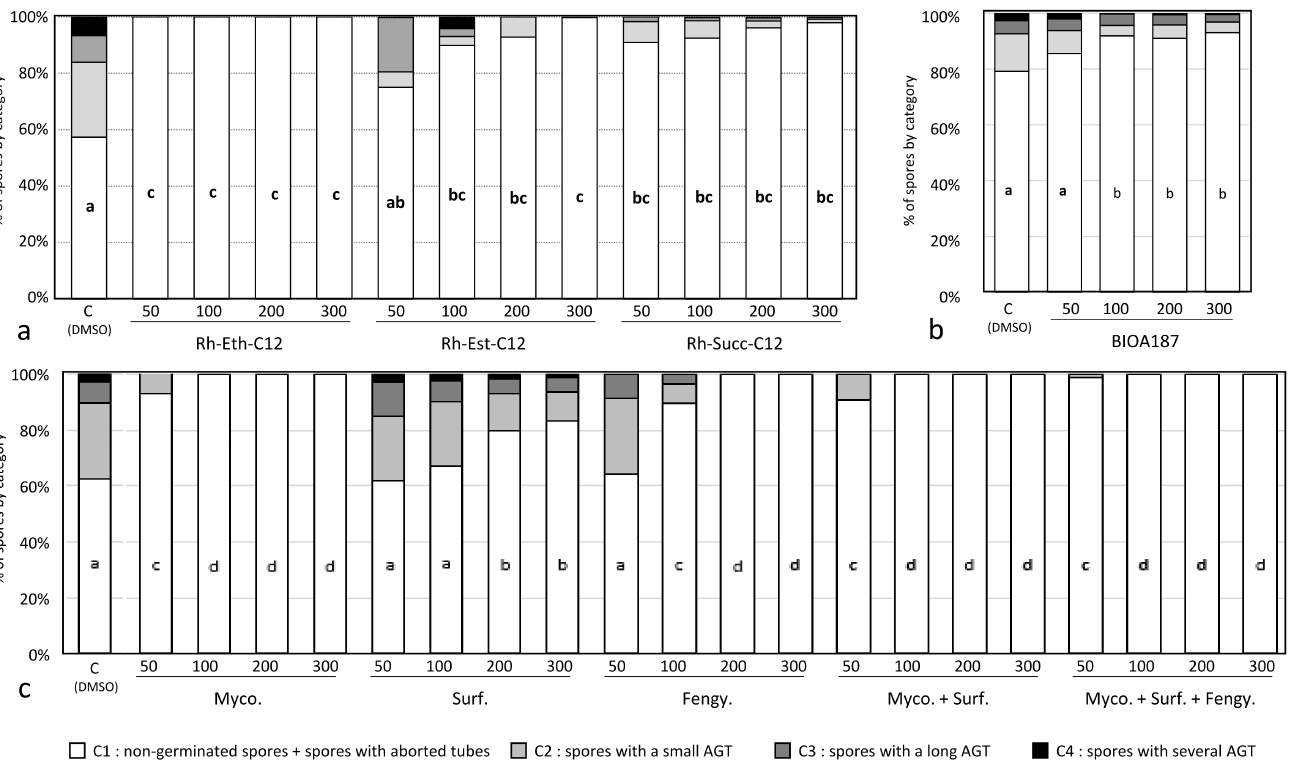
Figure 5. Effect of the molecules on the germination of B. graminis f.sp. tritici spores in vitro. The spores are classified in 4 different groups: C1, non-germinated spores + spores with aborted tubes; C2, spores with a small AGT; C3, spores with a long AGT and C4, spores with several AGT. The spores were in contact with synthetized rhamnolipids ( a ), BioA187 ( b ), lipopeptides and its mixtures ( c ) and 0.1% DMSO was used for the control (C). Germination was assessed 48 h after the dispersion of the spores on Petri dishes containing agar (12 g/L) supplemented or not with tested molecules diluted in 0.1% DMSO at various concentrations (50 to 300 µ M). Data represent means of 3 independent experiments. Values in C1 class with different letters are significantly different (ANOVA, p ≤